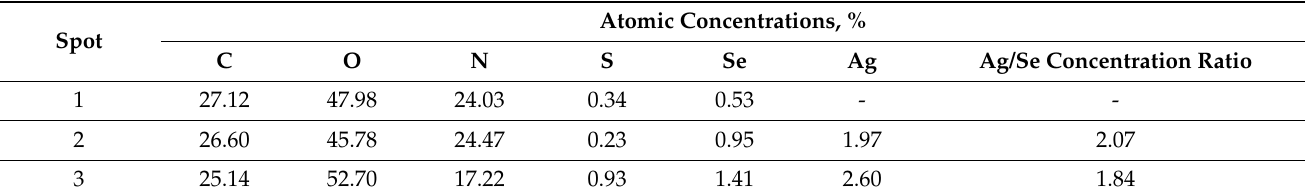
Table 5. Chemical composition from each fractional layer (spot 1, spot 2, and spot 3, as marked in Figure 3) of the Ag–Se-24/nylon nanocomposite obtained by EDS.